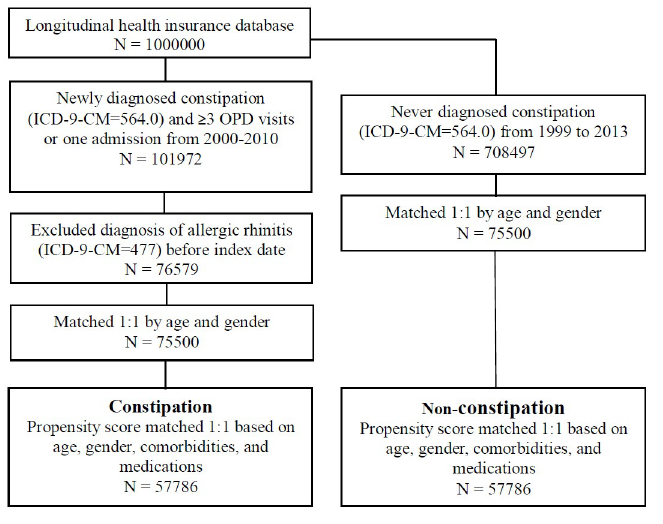
Fig 1. Flowchart of